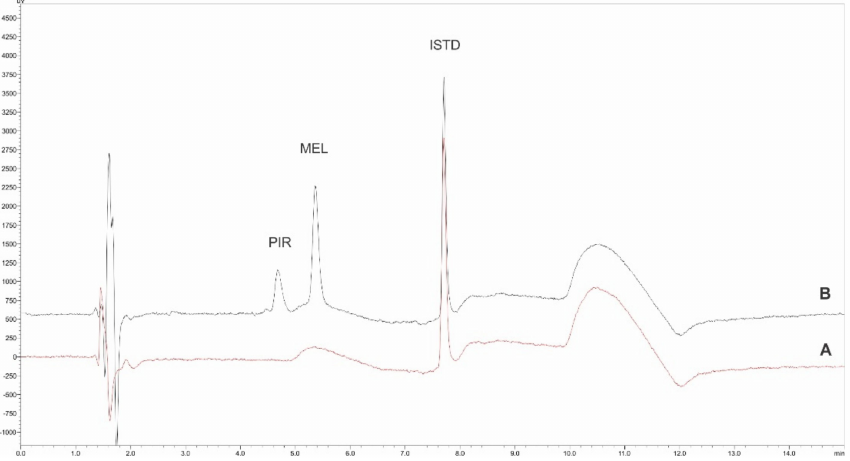
Figure 4. Representative HPLC-PDA chromatograms of a sample spiked with ( A ) ISTD and ( B ) ISTD and mixture of PIR and MEL at a concentration level of 0.1 µ g mL − 1